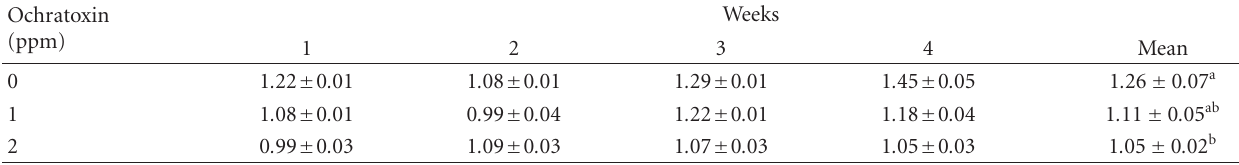
Table 5: Mean ( ± S.E.) serum albumin g/dL values of broiler chickens fed